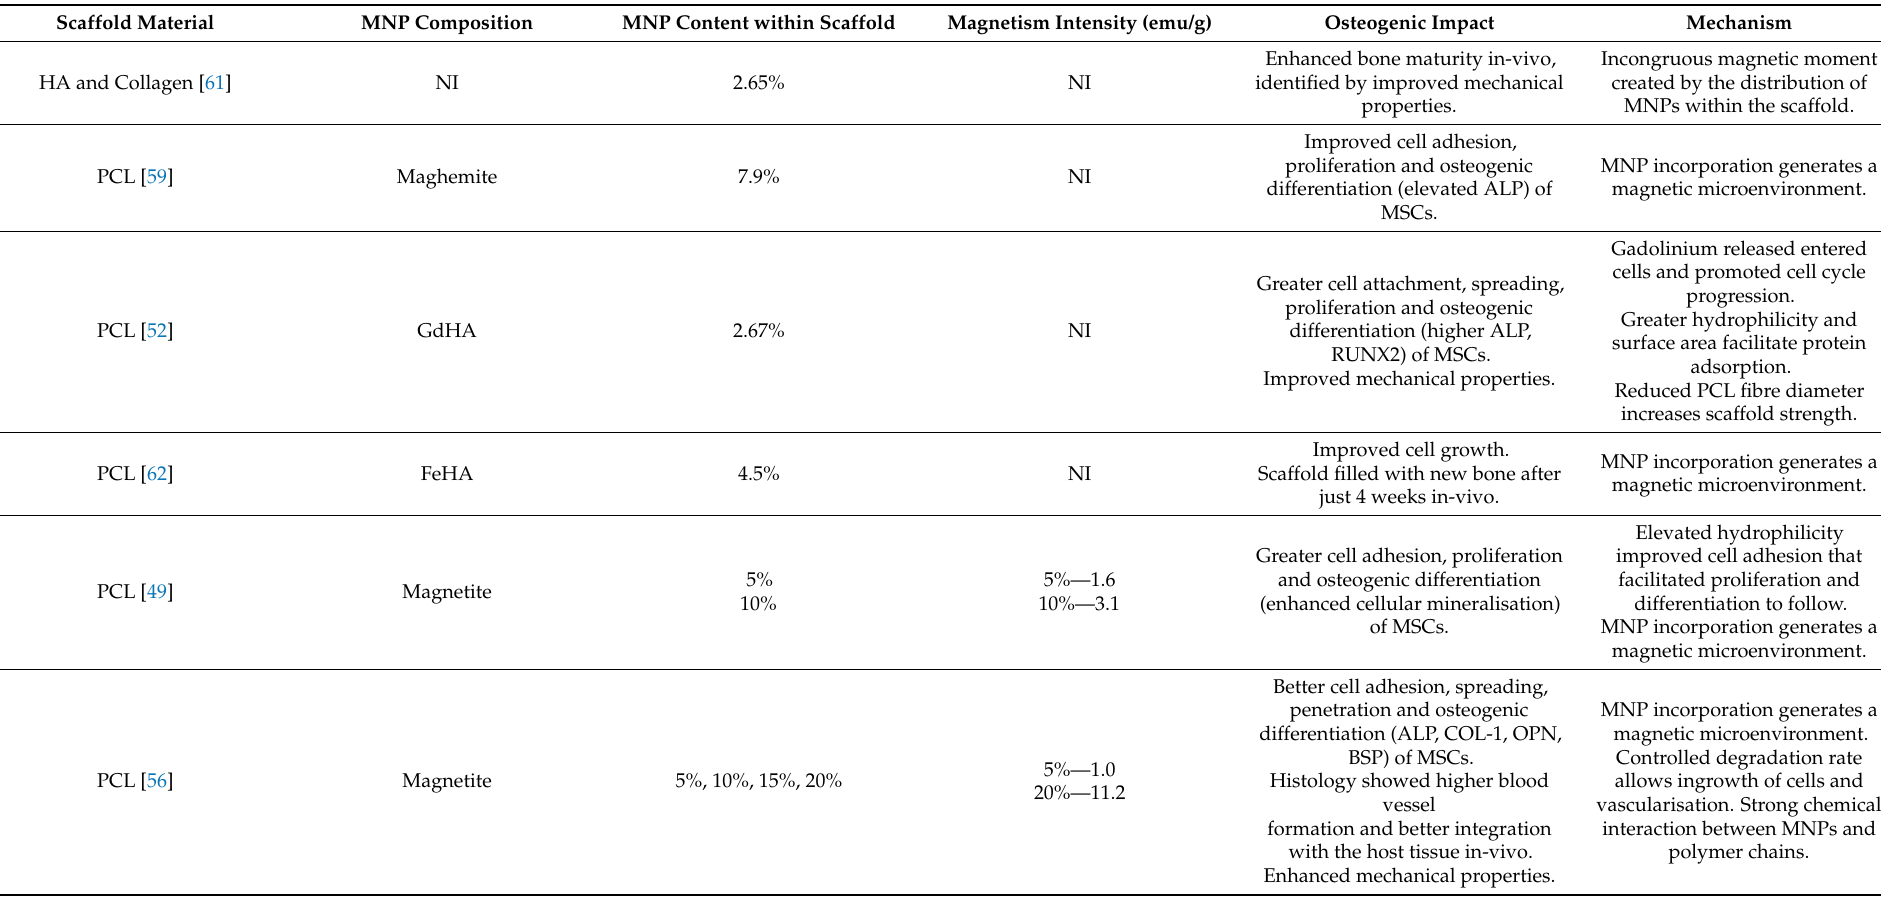
Table 1. A table summarising the various studies that investigated the impact of MNP-incorporated scaffolds on